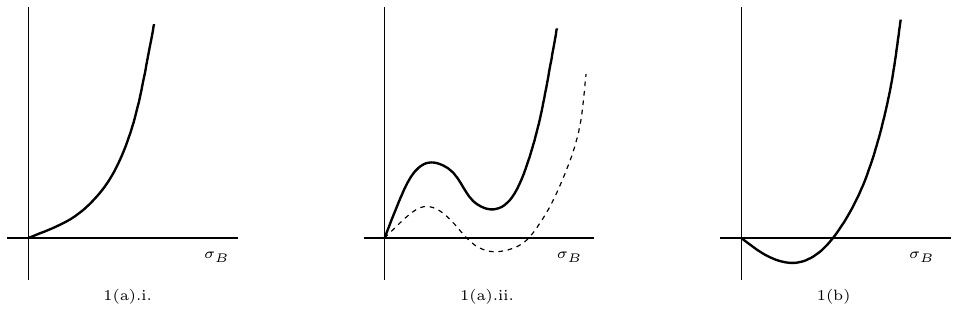
Figure 1 . E(cid:11)ective potential in the Higgsed phase for A h